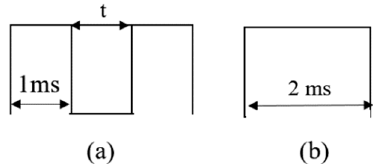
Figure 3. Two stimuli, ( a ) test and ( b ) reference, simulating a key click effect used for the psychophysical experiment. The time interval ( t ) between two peaks was controlled during the experiment.